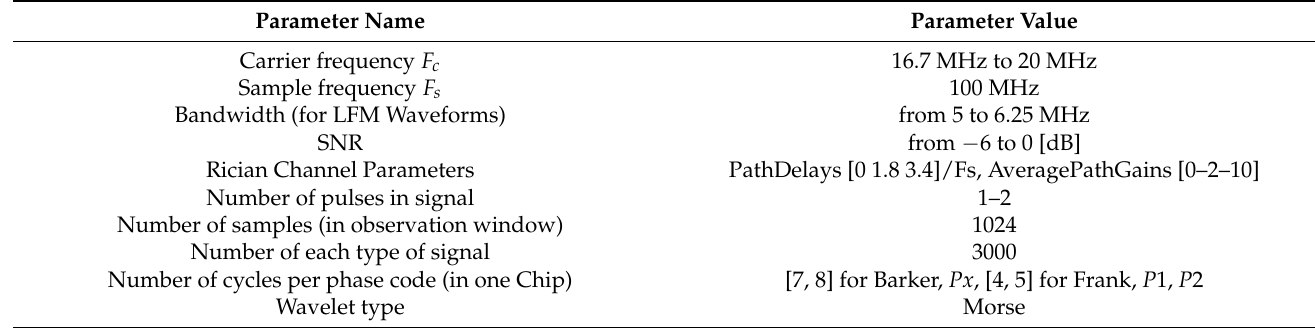
Table 2. General simulation parameters.